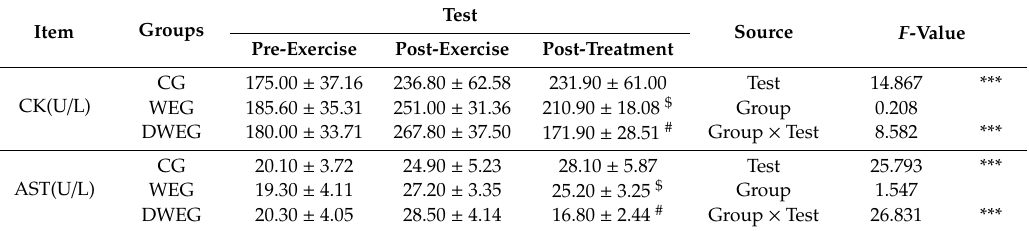
Table 5. Changes in enzyme levels during exercise-induced muscle